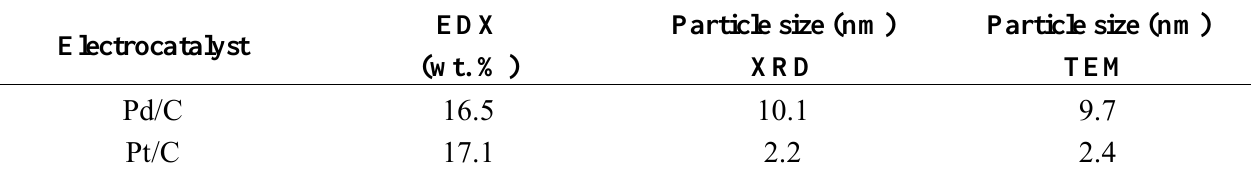
Table 1. Chemical composition and characteristics of supported Pd and Pt electrocatalysts.